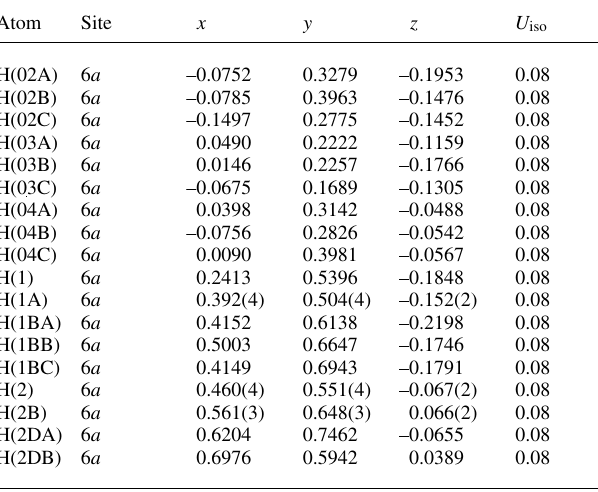
Table 2. Atomic coordinates and displacement parameters (in Å 2 )